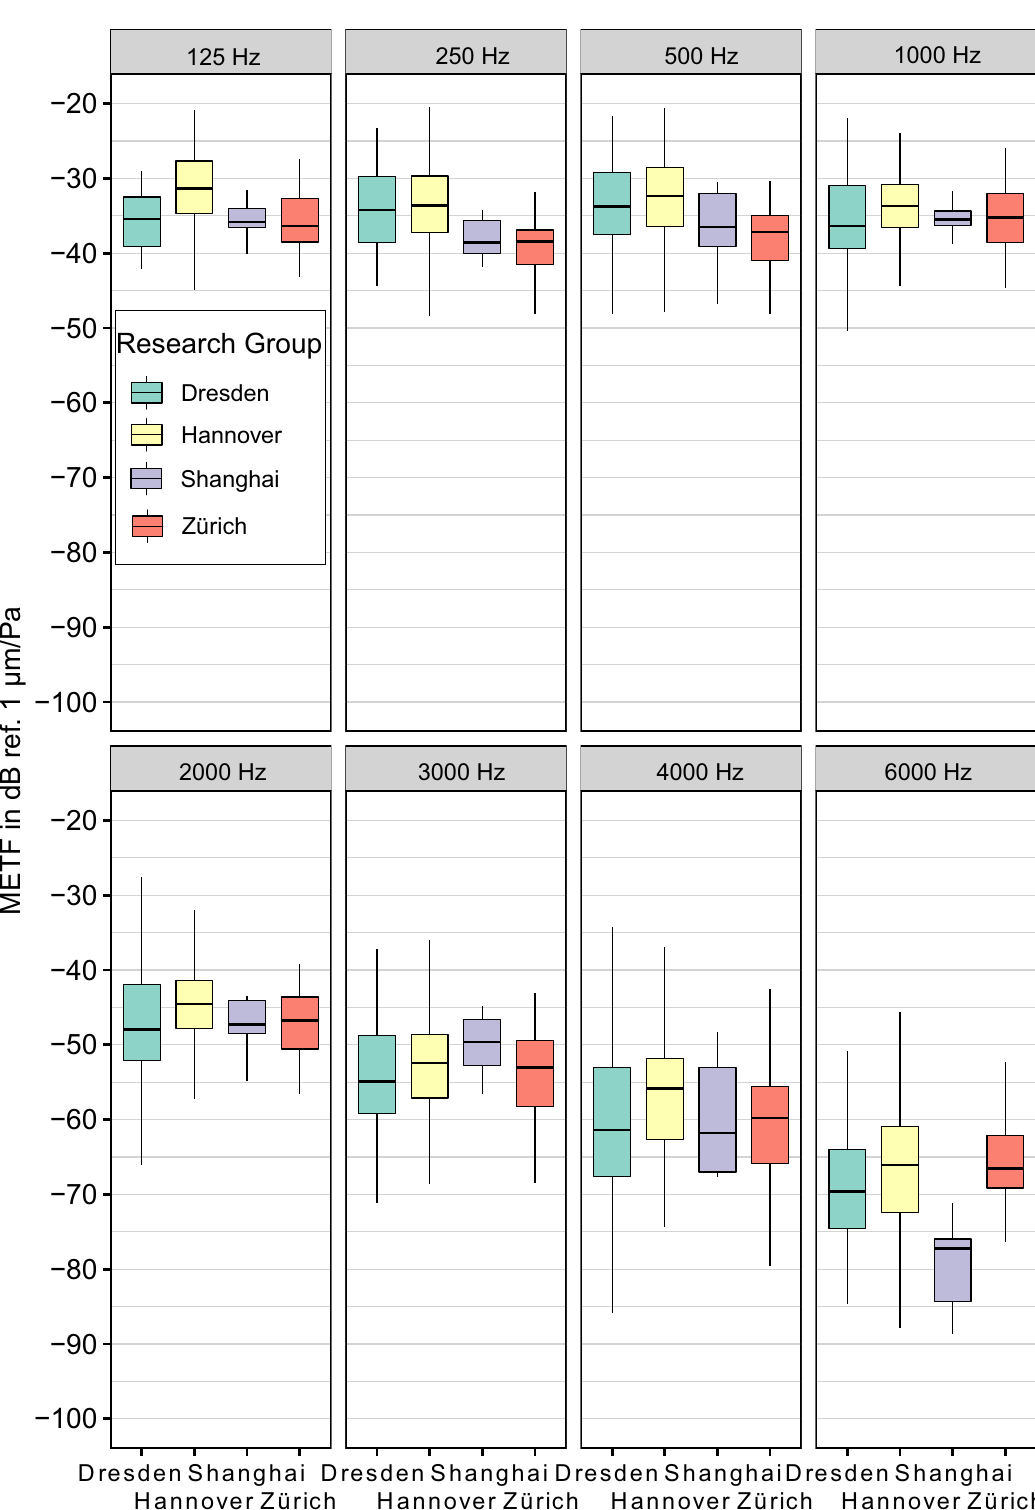
Figure 4. Comparison of METF data from different research groups by frequency. All groups use single point LDV measurements on the stapes footplate as output signal (method A). Median Magnitudes and quartiles without outliers are depicted. Complete results of the corresponding Welch t-tests are listed in